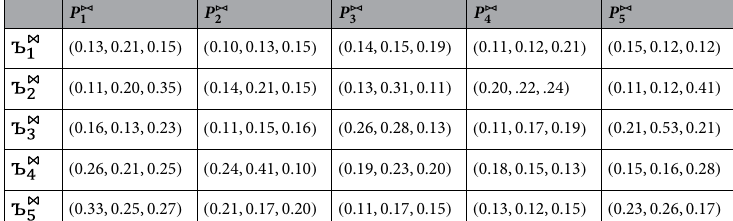
Table 6. Picture fuzzy soft data for F